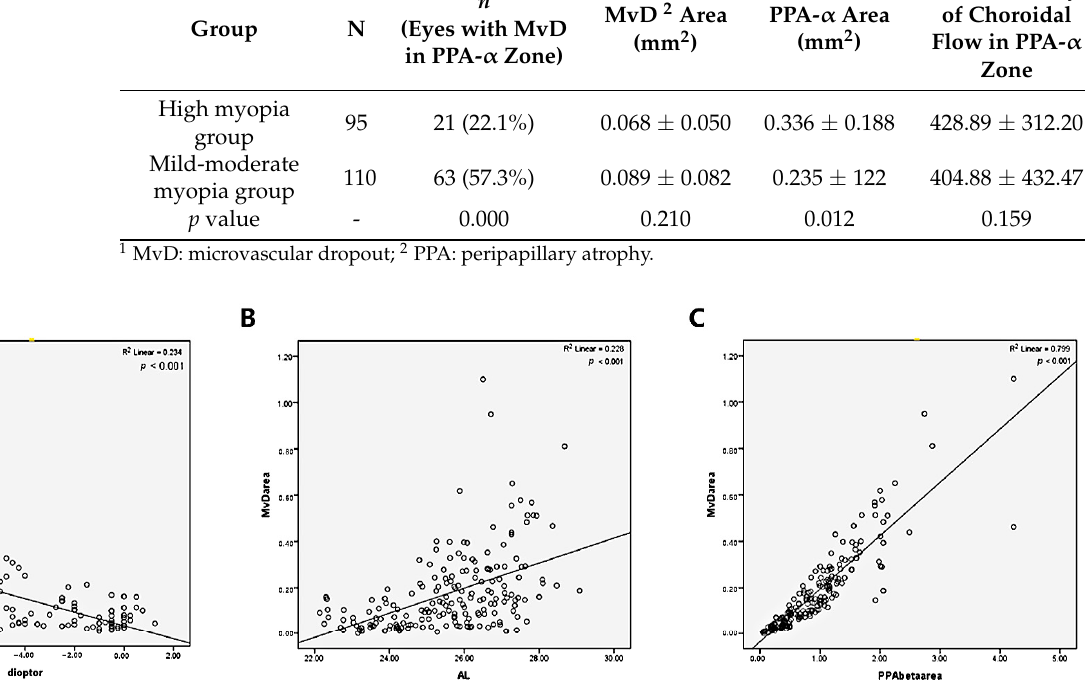
Figure 3. Correlation analysis between MvD area and spherical equivalent (SE), axial length (AL), and the area of PPA- β zone. MvD area was negatively correlated with ( A ) SE whereas positively correlated with ( B ) AL and ( C ) the area of PPA- β